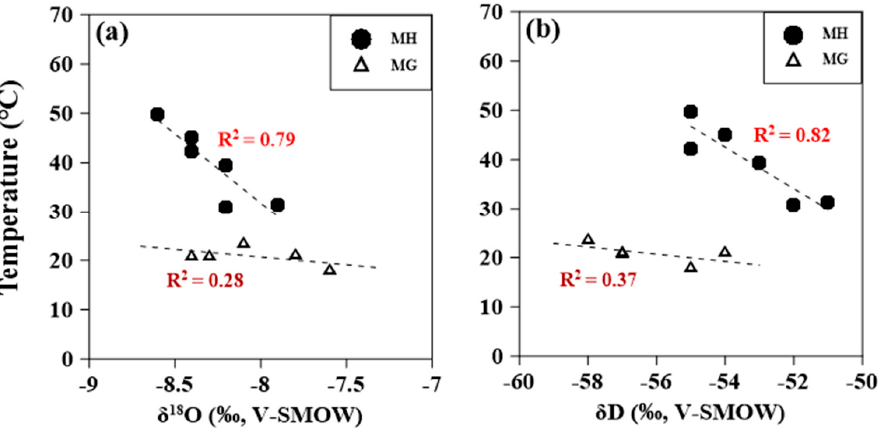
Figure 8. Relationships between temperature and δ 18 O ( a ) and δ D ( b ) of the thermal waters (MH) and groundwaters (MG).